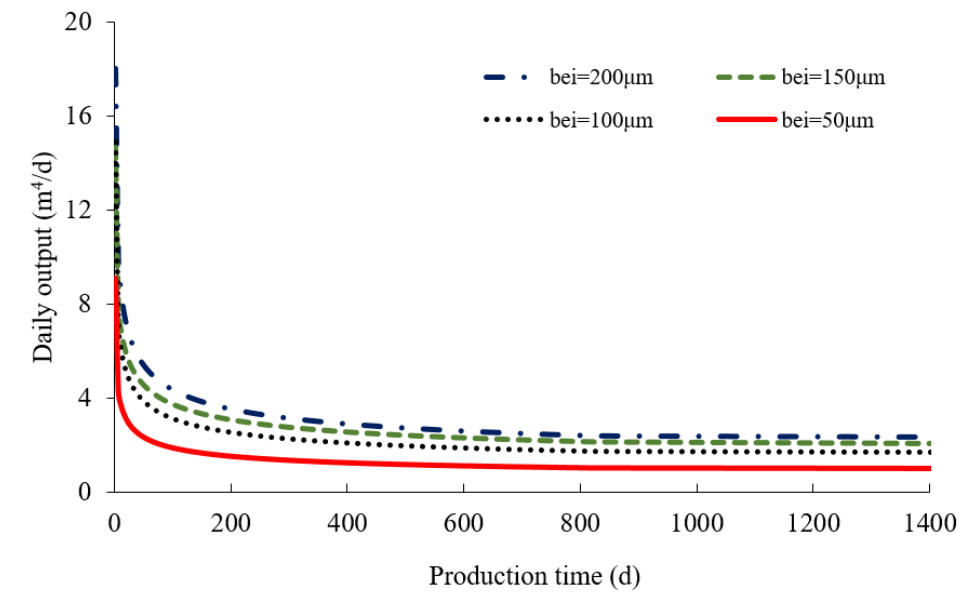
Figure 6. The influence of initial average aperture of fractures on the daily gas production.